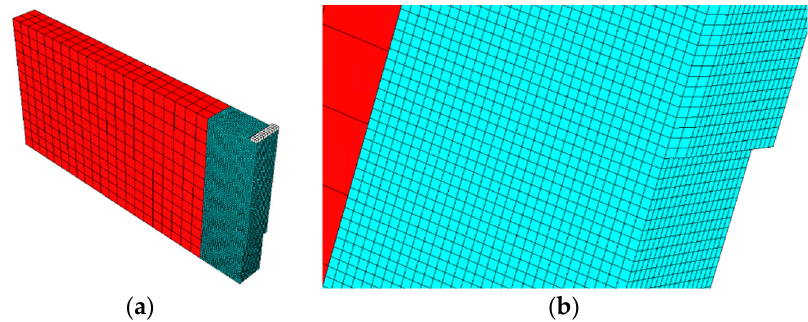
Figure 10. Adopted 3D mesh ( a ) and magnification of the proposed UMAT area ( b ) for the three- point bending